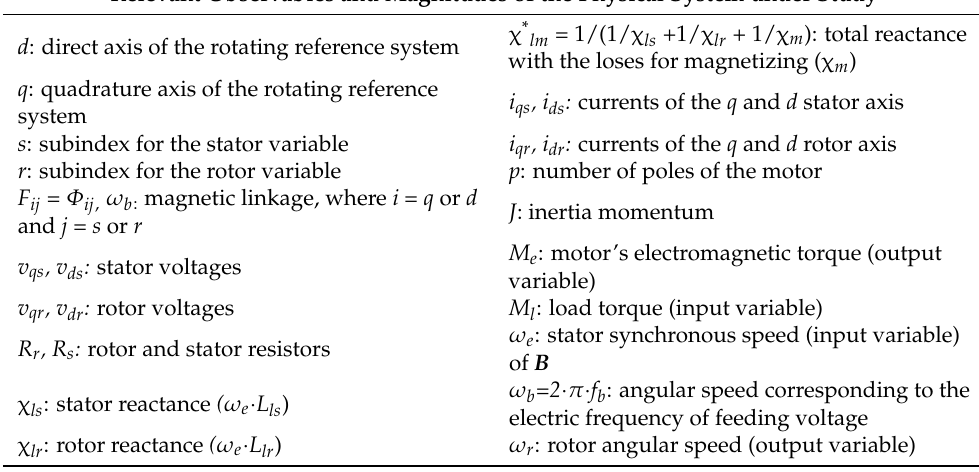
Figure 6. Dynamic equivalent circuit of an IM along the d -axis of the rotating reference system.